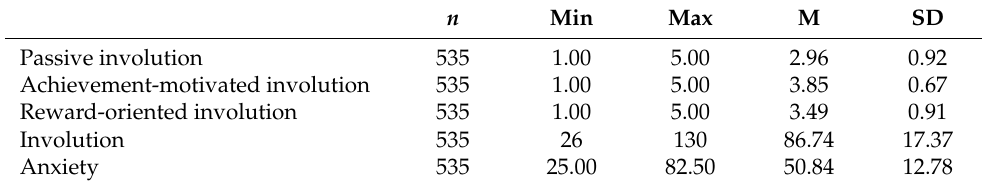
Table 5. Descriptive statistics among study